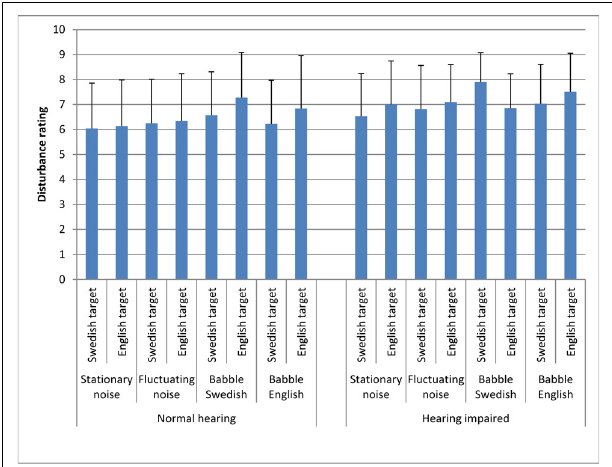
FIGURE 2 | Means and SDs of the perceived disturbance ratings for the NH and HI participants in Swedish and English target with stationary noise, fluctuating noise, babble Swedish, and babble